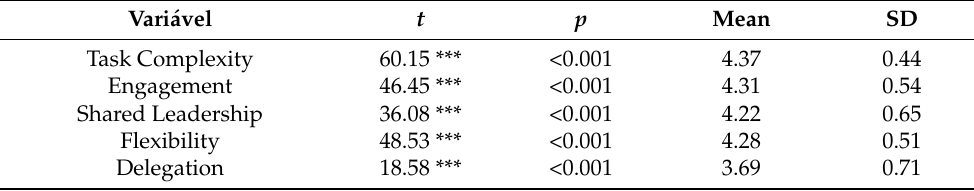
Table 1. Results of Student’s t -test for one sample. Vari á vel t p Mean SD Task Complexity 60.15 *** <0.001 Engagement